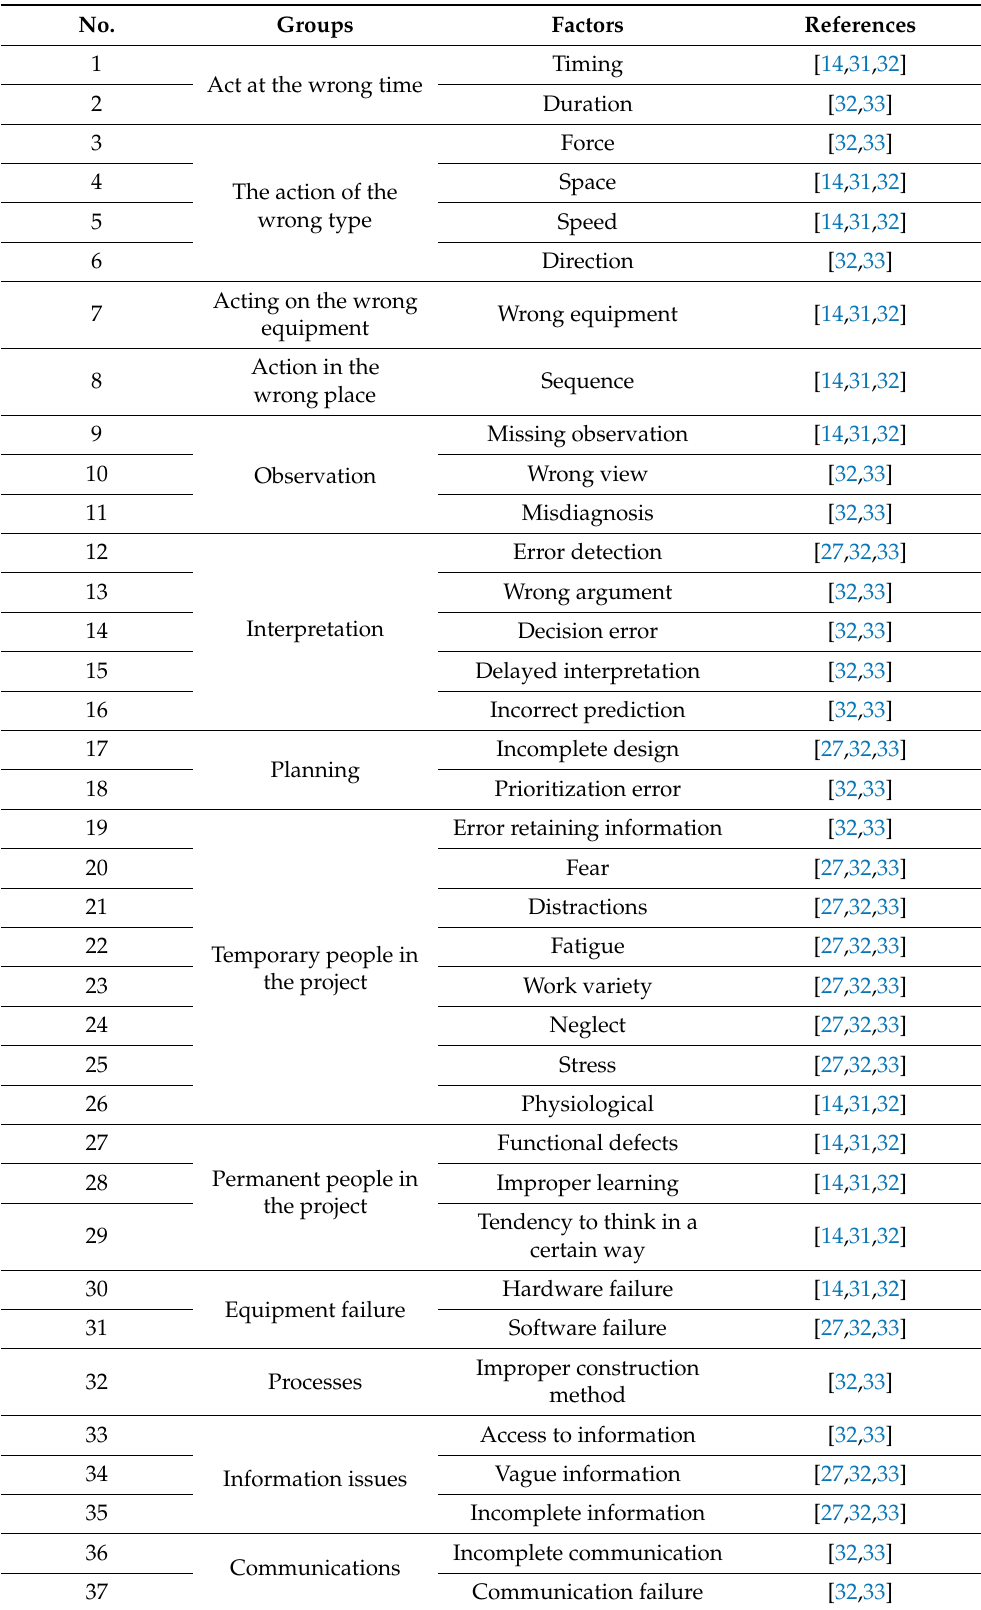
Table 1. Key factors contributing to human errors based on the review of the reported literature.